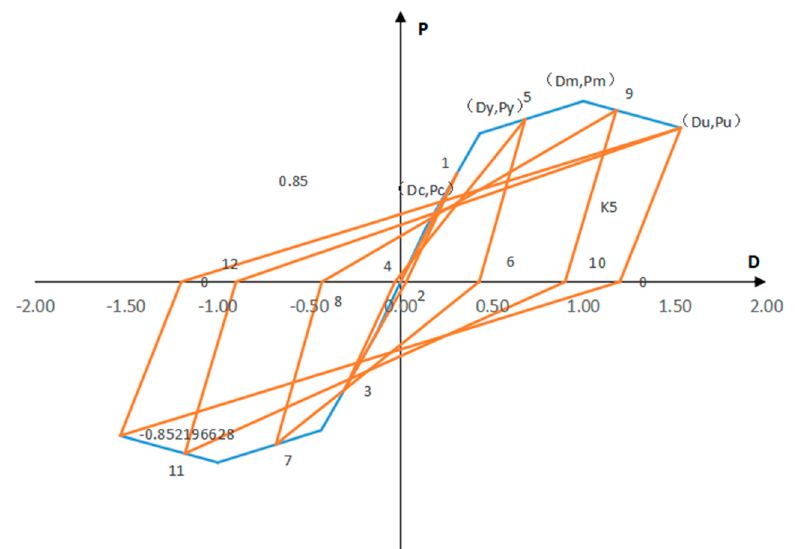
Figure 13. Schematic diagram of loading and unloading paths.